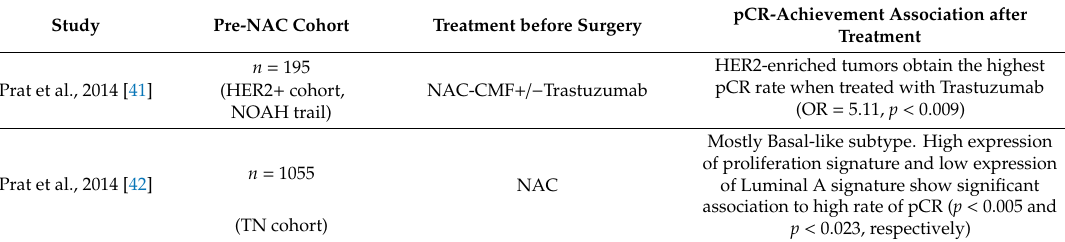
Table 2. Studies evaluating PAM50 as a predictive tool for